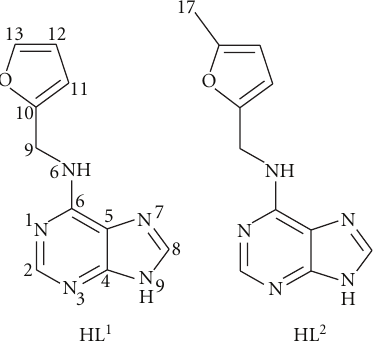
Figure 1: The organic compounds (N6-furfuryladenine, left; N6- (methylfurfuryl)adenine, right) used as ligands in the presented